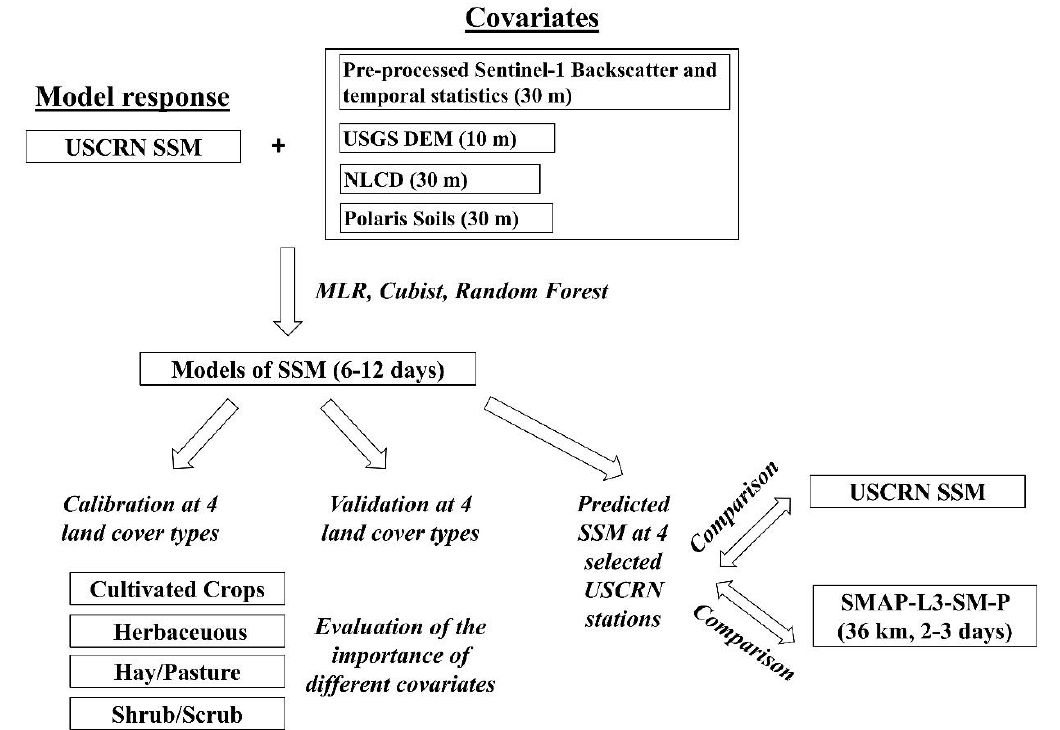
Figure 2. Block diagram of the method used in this study.